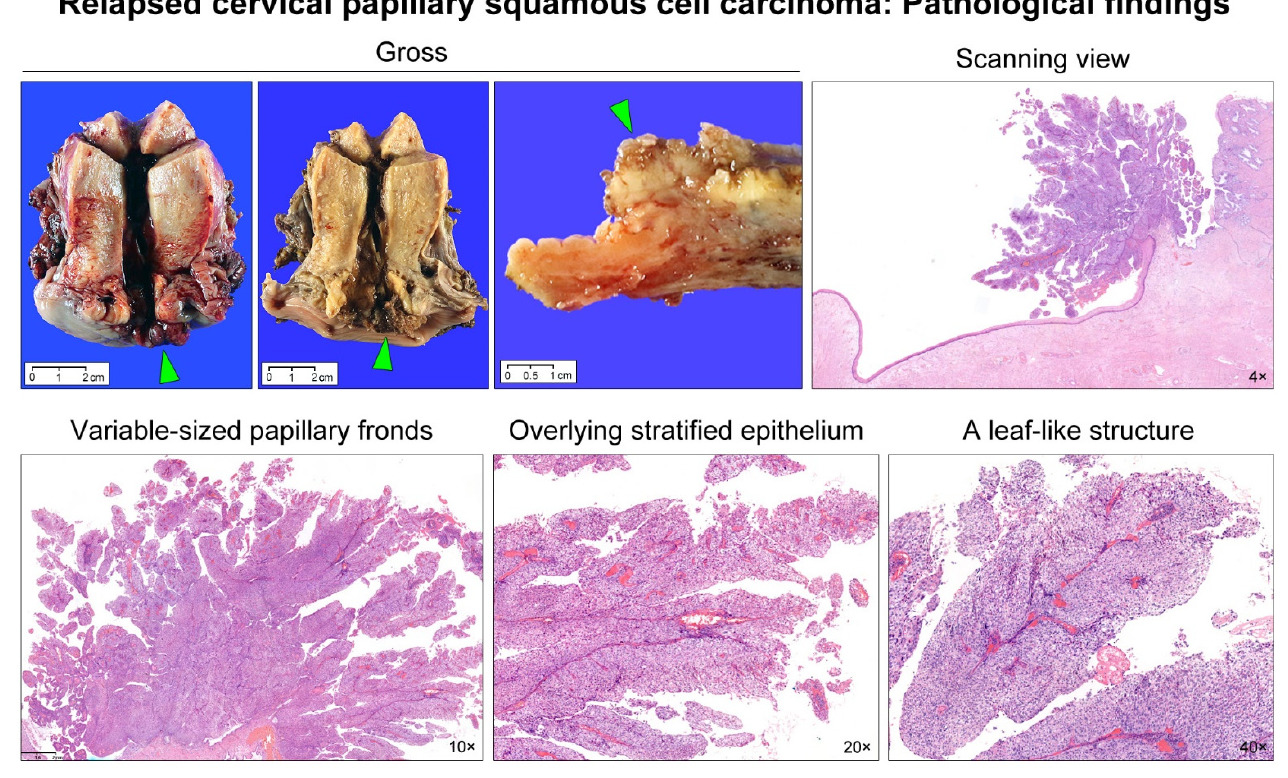
metastases are developed nine months postoperatively (yellow arrowheads). Axial MRI and PET show two enlarged and hypermetabolic lymph nodes in the right obturator area.